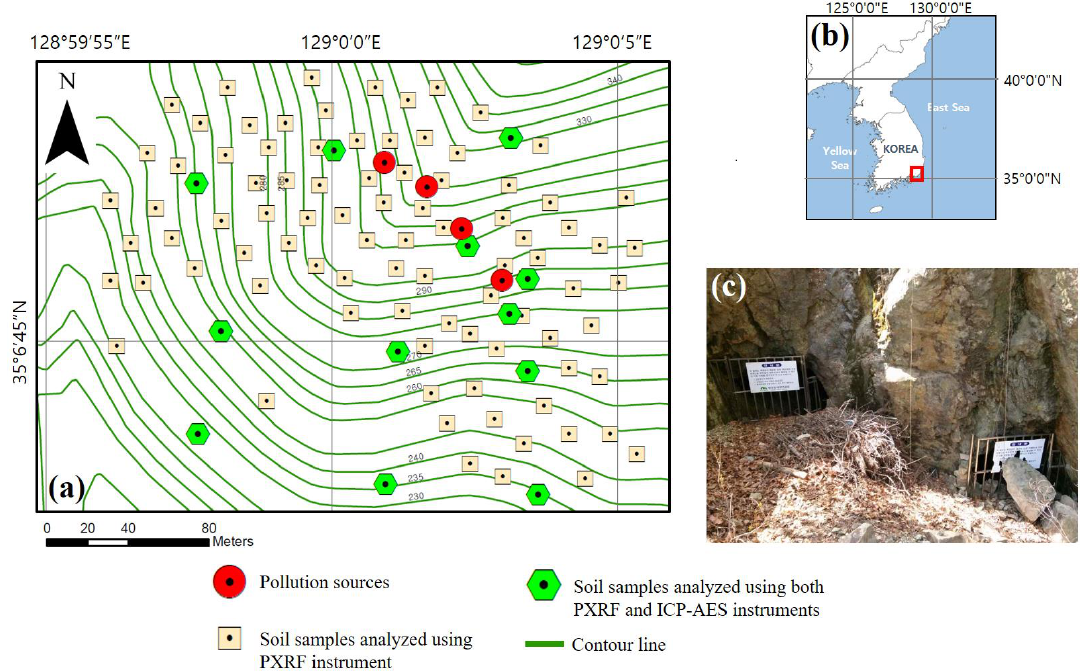
Figure 1. Study area: ( a ) Locations of pollution sources and soil sampling points for ICP-AES and PXRF analyses; ( b ) Study area location in Korea; ( c ) Photograph of closed pit heads at the Busan mine.